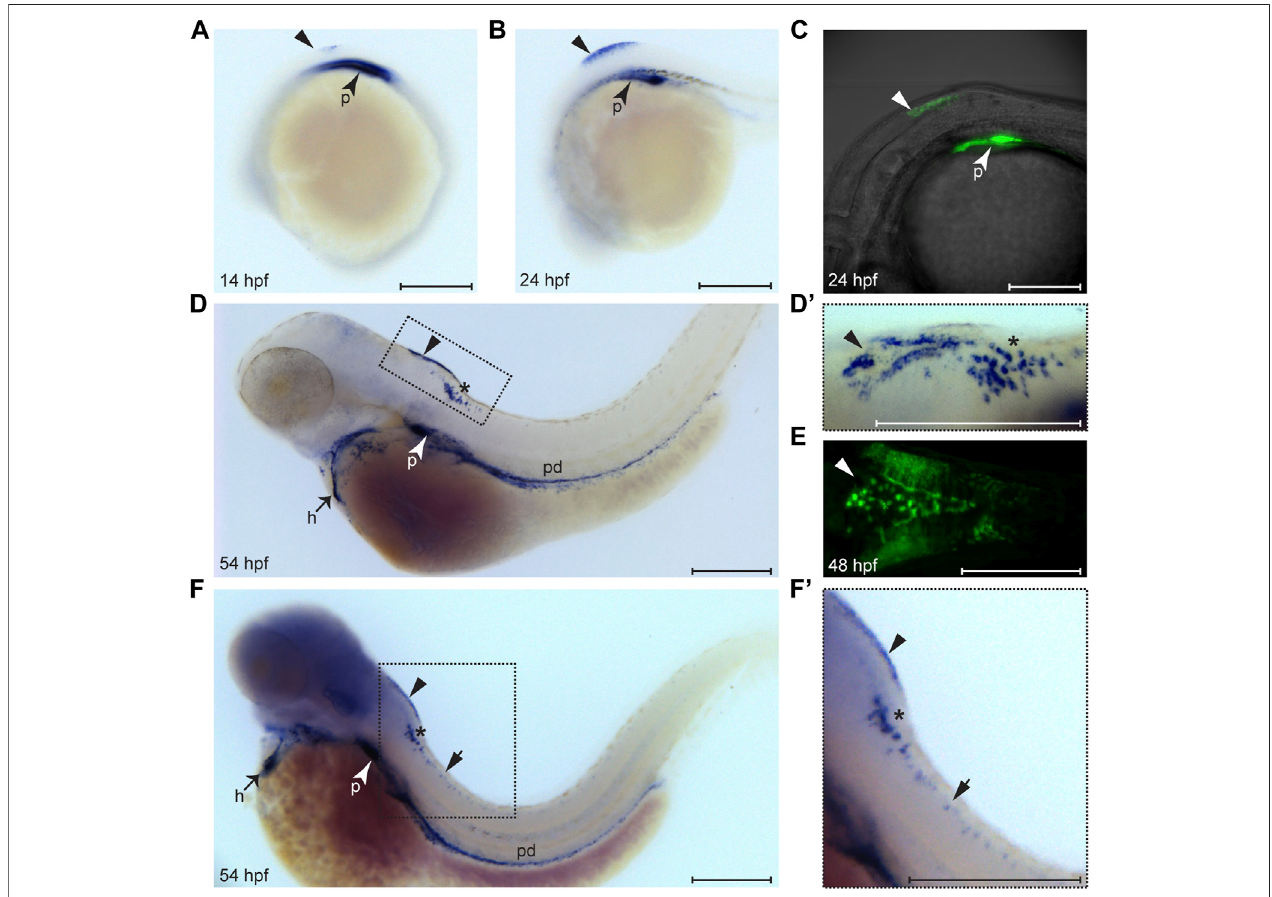
FIGURE1| Expressionpatternof wt1a duringembryonicandlarvaldevelopment. Wt1a expressionwasanalyzedbywholemount insitu hybridization (A,B,D,D 9 , F,F 9 ) andviaexaminationoftheEGFPsignalinanimalscarryingthe wt1a:EGFP transgene(C,E). (A) Inadditiontotheknownandprominentexpressioninthedeveloping pronephros (arrowhead), weak expression of wt1a is present in the presumptive dorsal hindbrain at 14 hpf (triangle). (B) The dorsal hindbrain domain appeared more prominent at 24 hpf. (C) Overlay of transmission and fl uorescent images of a Tg ( wt1a:EGFP ) embryo reveals that the domain described in B is located at the most posteriorregionofthehindbrain. (D) At54hpf wt1a expressionisdetectedinthepronephros,intheheart,alongthepronephricductandintwodomainsofthehindbrain. In addition to the above mentioned very dorsally located domain (arrowhead) the wt1a transcript is also present in a more ventral region (asterisk). (D 9 ) A closer, dorsolateral view on both hindbrain domains illustrates that the dorsal domain (arrowhead) has a triangular shape with a compact structure in the middle. (E) The EGFP signalarisingfroma2 dayoldembryoofthe wt1a transgeniclinecloselyrecapitulatesthev-shapedexpressiondescribedinD ’ . (F-F 9 ) Uponextendedstainingofa54hpf larva wt1a expressing cellsarealsodetectableinthespinalcord(shortarrow). A-D,Fand F ′ arelateral views,D ′ isadorsolateral and Eaventralview.Allimagesarewith rostral to the left. h: heart; p: pronephros; pd: pronephric duct. Scale bars: 200 μ m.